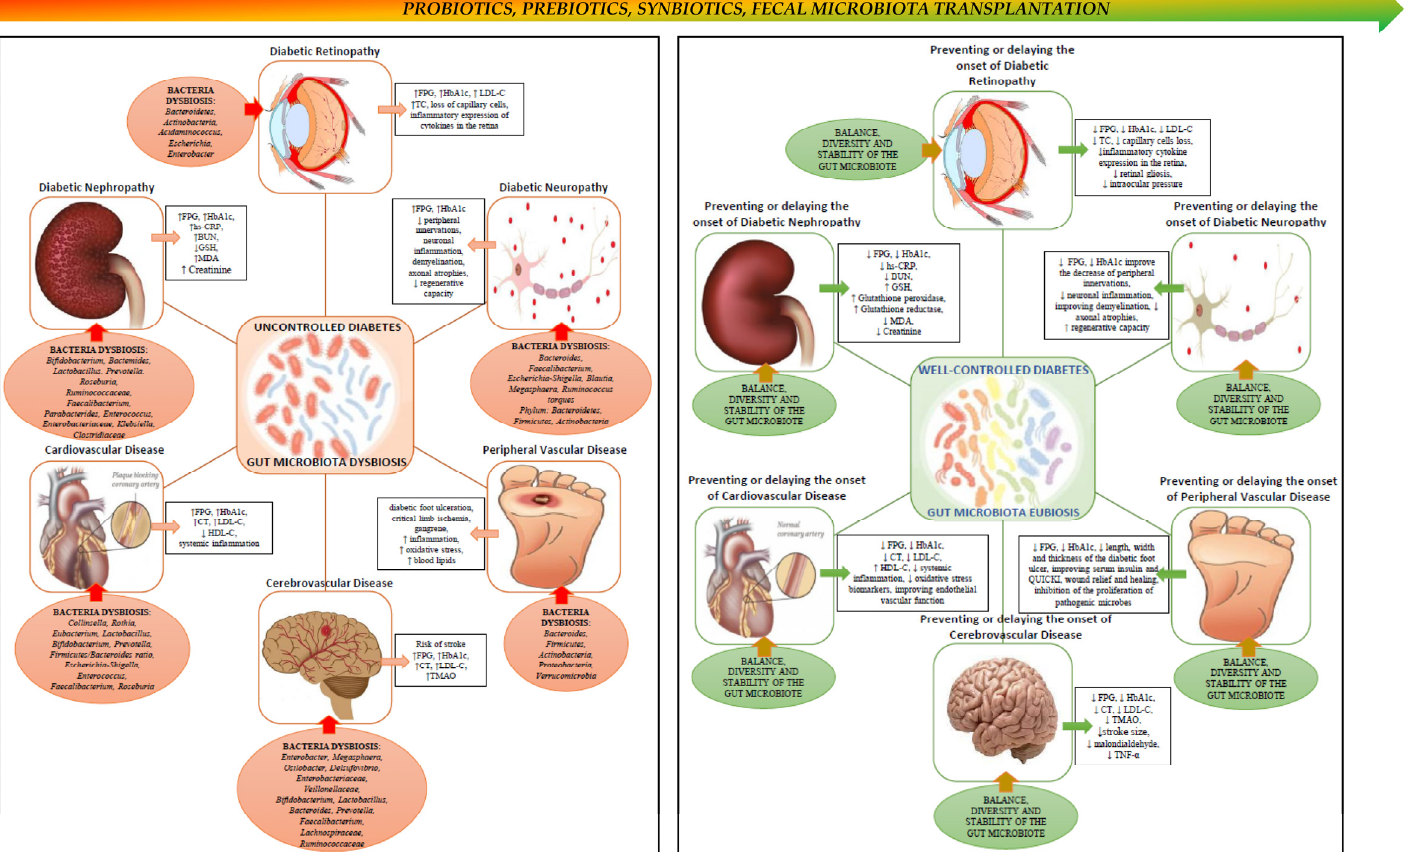
Figure 1. Schematic view of the link between gut microbiota, diabetes and chronic complications of diabetes. The left side panel depicts chronic micro- and macrovascular complications of diabetes, and associated changes in the composition of the gut microbiota. Poorly controlled diabetes leads to chronic complications over time, and dysbiosis of the gut microbiota seems to promote the onset and progression of these complications. The right panel depicts the potential effects of restoring gut microbiota eubiosis in ameliorating, preventing or delaying the onset of chronic complications of diabetes, via probiotics, prebiotics, symbiotics or by fecal microbiota transplantation. ↑ , increase; ↓ , decrease.